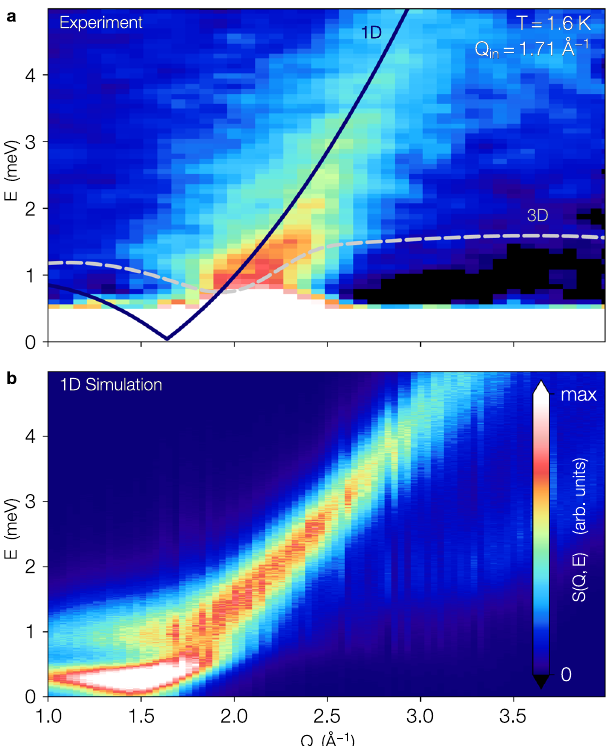
Fig. 3 Inelastic scattering of a 1D quantum liquid. a The dynamic structure factor, S ( Q , E ), from helium con fi ned in the Ar plated pores of MCM-41. The scattering was measured at a fi lling of 13 mmol g − 1 , corresponding to full pores, and the background from the Ar/MCM-41 matrix has been removed with the elastic scattering suppressed. The most prominent feature is the strong excitation that begins at ~1.6 Å − 1 at E = 0 and extends to high energy. This is quite distinct from the scattering that would be expected from either bulk 4 He or that of 4 He con fi ned in larger pores where the scattering would be described by the phonon-maxon-roton excitation curve (gray dashed line). For the bulk liquid, the scattering would be most intense around the roton minimum at Q r ≃ 1.9 Å − 1 and would plateau at twice the roton energy (~1.5 meV). The purple line shows a theoretical prediction for the threshold energy of a purely 1D quantum liquid of hard spheres with emergent Fermi wavevector 2 k F = 1.6 Å − 1 and dimensionless Tomonaga-Luttinger liquid parameter K ≃ 1.2. The value for k F has been obtained from S ( Q , 0), while K comes from fi tting the inelastic branch of S ( Q , E ) (see Fig. 4). b The dynamic structure factor of a purely 1D system of 4 He at T = 1.6 K obtained via numerical analytic continuation of the imaginary time scattering function measured via quantum Monte Carlo for a system with L = 200 Å . The density was chosen to produce a value of K similar to that seen in the